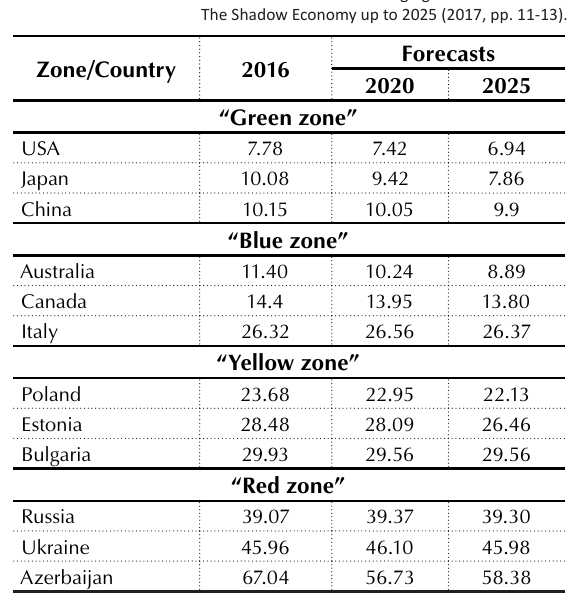
Table 1. Forecasts of the size of shadow economies (% GDP) in some countries in the world according to ‘colored’ zones of